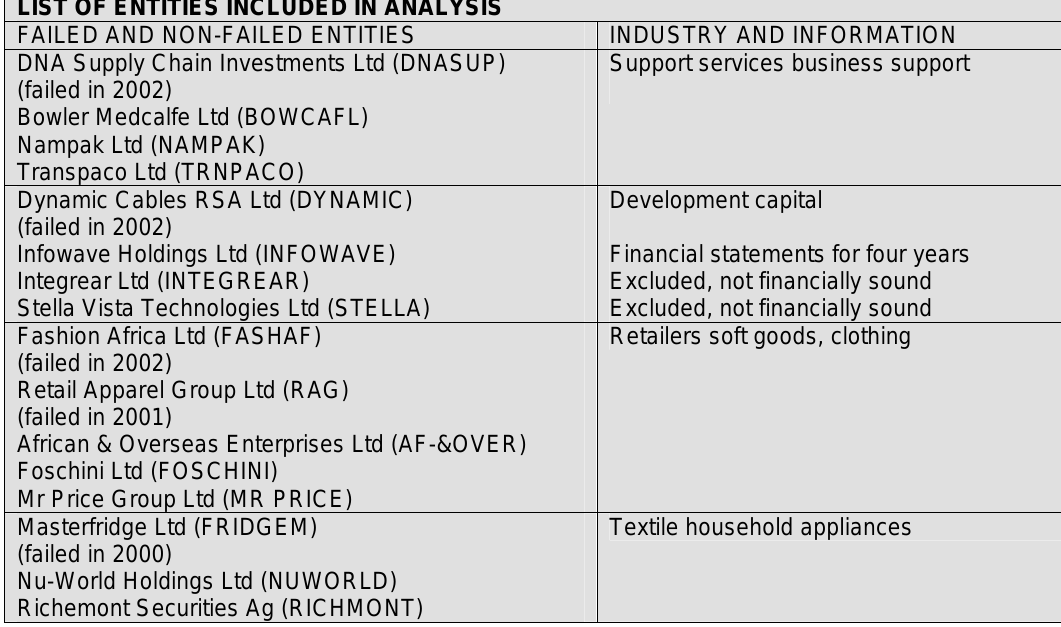
Table 2: List of entities included in analysis LIST OF ENTITIES INCLUDED IN